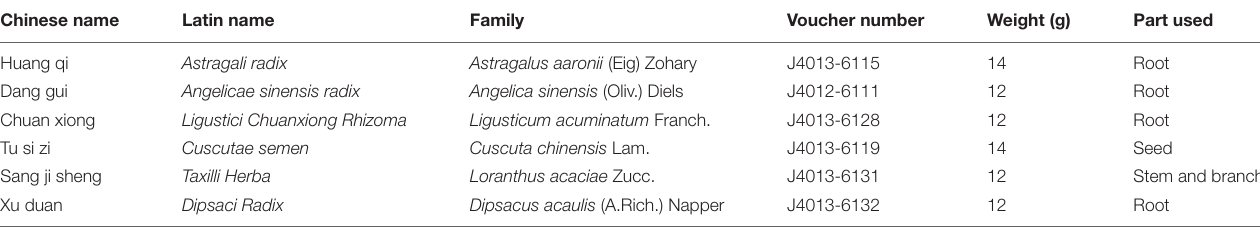
Frontiers in Pharmacology |